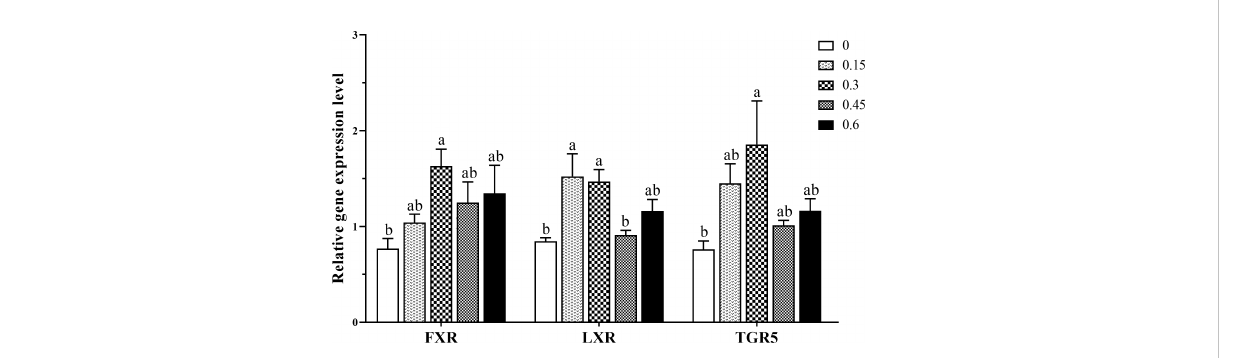
FIGURE 5 Gene expression levels of bile acids receptors in the intestine of coral trout responded to the different dietary bile acids levels. Values are expressed as mean ± S.E.M (n=6). Different letters indicate signi fi cant differences among groups ( P < 0.05). FXR, Farnesoid X receptor; LXR, liver X receptor; TGR5, G-protein-coupled bile acid